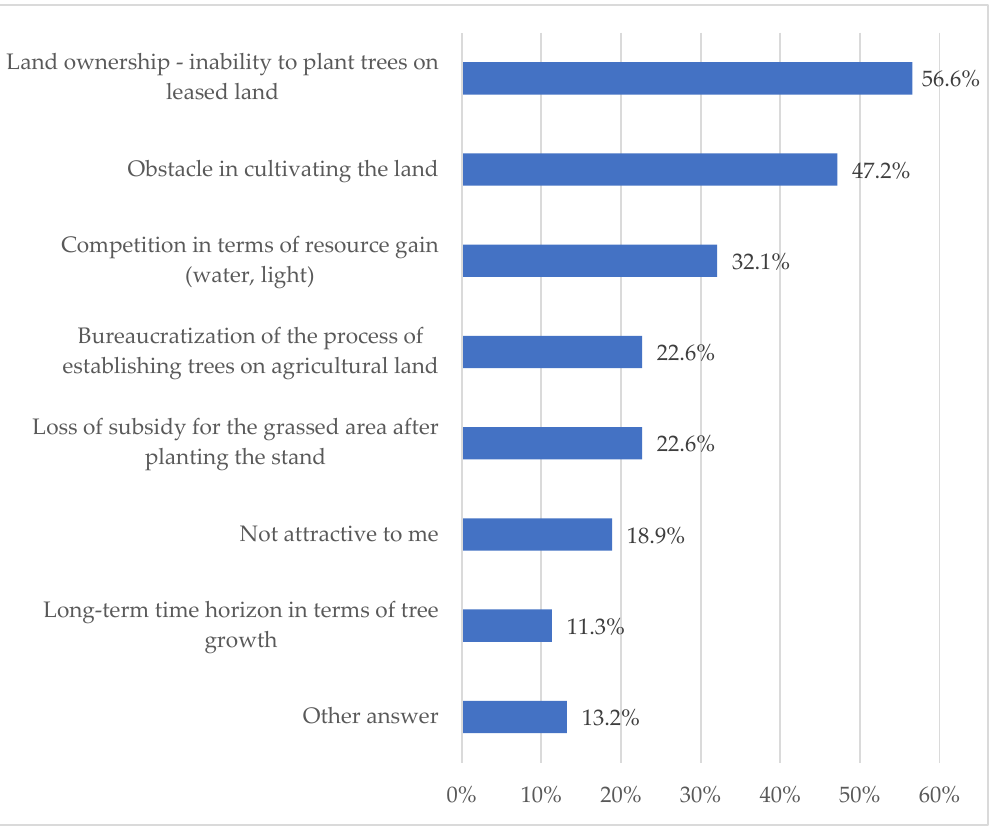
Figure 2. Reasons for not growing trees on cultivated land (multiple choice; n = 53).